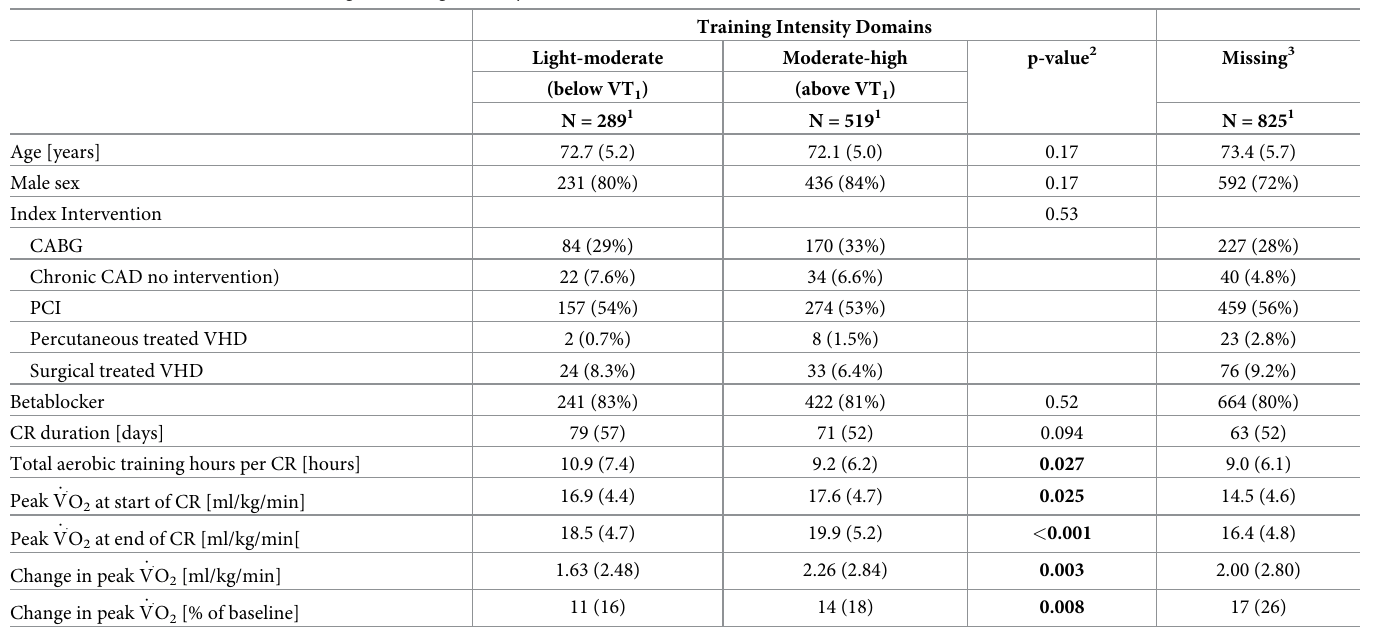
Table 3. Patient characteristics according to training intensity